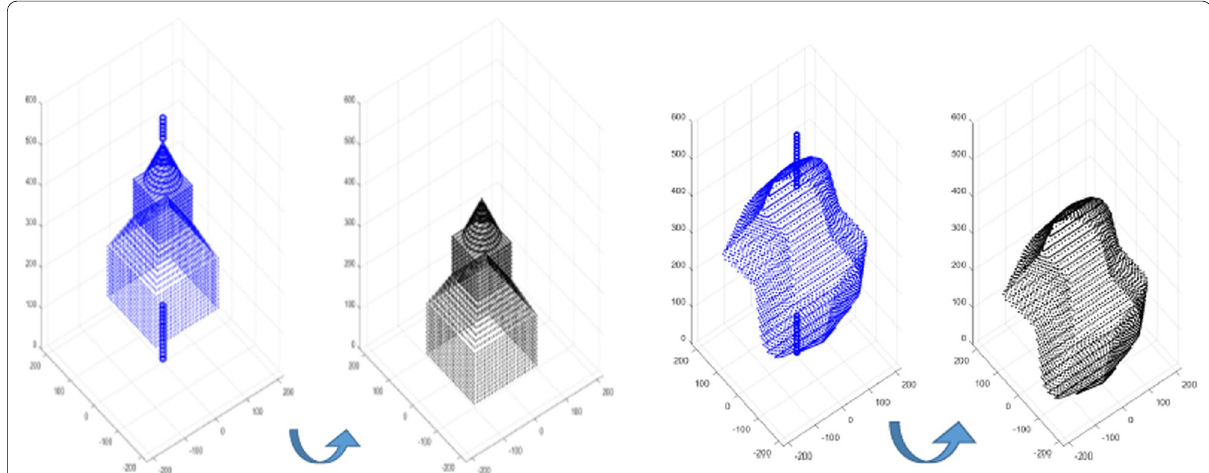
Fig. 3 Examples after applying the model preparation module